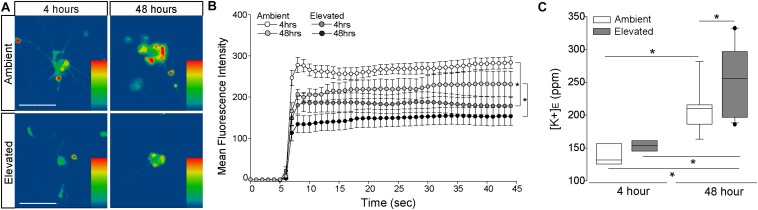
Elevated pressure decreases inward cation flux and increases extracellular K+ concentration in RGCs in vitro. (A) Representative heat maps showing the fluorescent signal of Thallos dye in RGCs exposed to ambient (top) and elevated (bottom) pressure for 4 h (left) or 48 h (right). Images were taken after the addition of thallium. Scale bar = 100 μM. (B) Line graph displaying the mean fluorescence intensity of Thallos dye over time for RGCs exposed to ambient or elevated pressure for 4 or 48 h. ∗p < 0.05 and error bars represent SEM. n(AMB4) = 30 cells, n(ELEV4) = 27; n(AMB48) = 6, and n(ELEV48) = 9. (C) Extracellular K+ concentration in RGC culture media following 4 h (left) or 48 h (right) of ambient (white) or elevated (gray) pressure, as measured by inductively coupled plasma mass spectrometry. ∗p < 0.05. n(AMB48) = 9 wells, n(ELEV48) = 12, n(AMB4) = 7, and n(ELEV4) = 7.